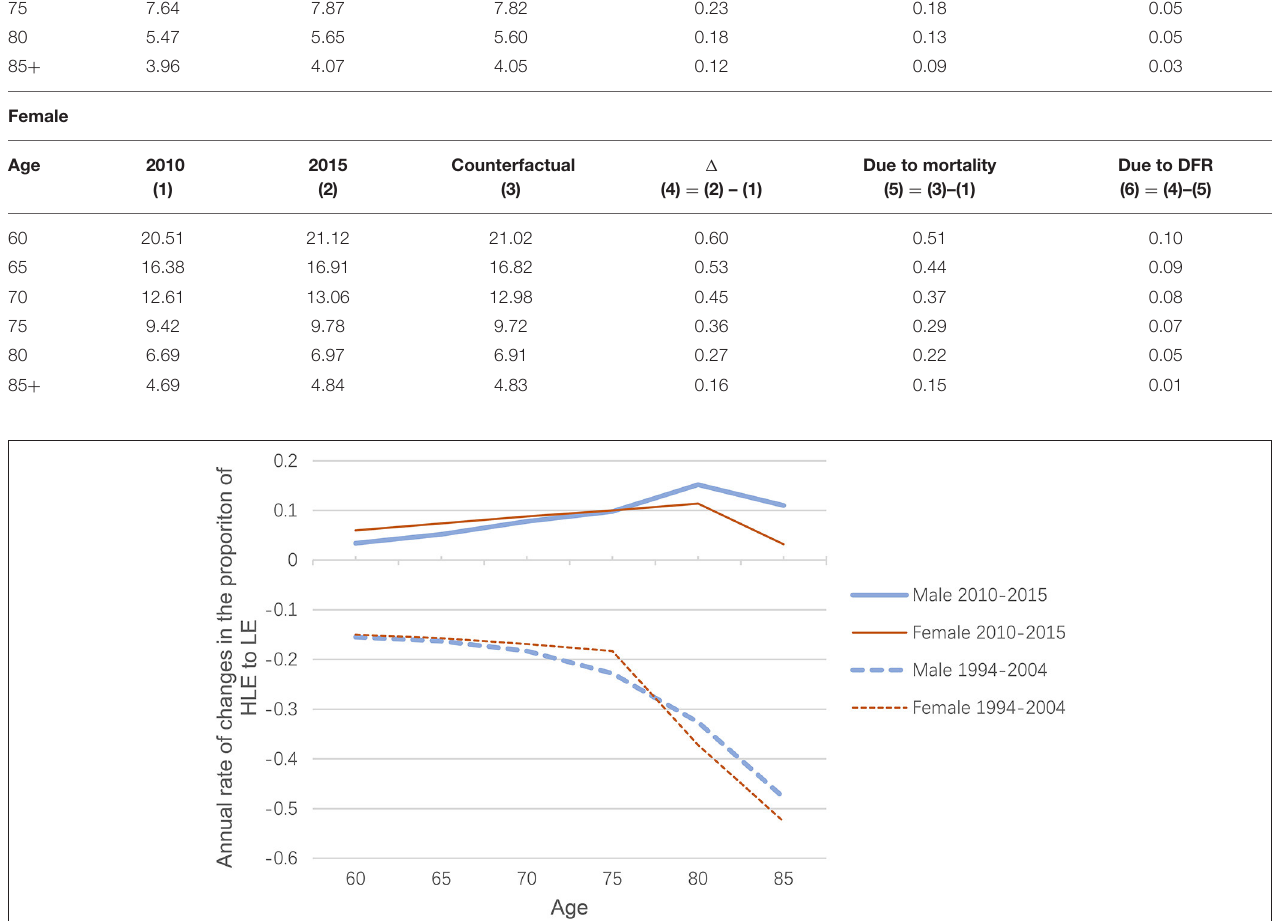
FIGURE 1 | Age-specific rate of annual change in the proportion of HLE to LE for both sexes, 1994-2004 and 2010-2015.